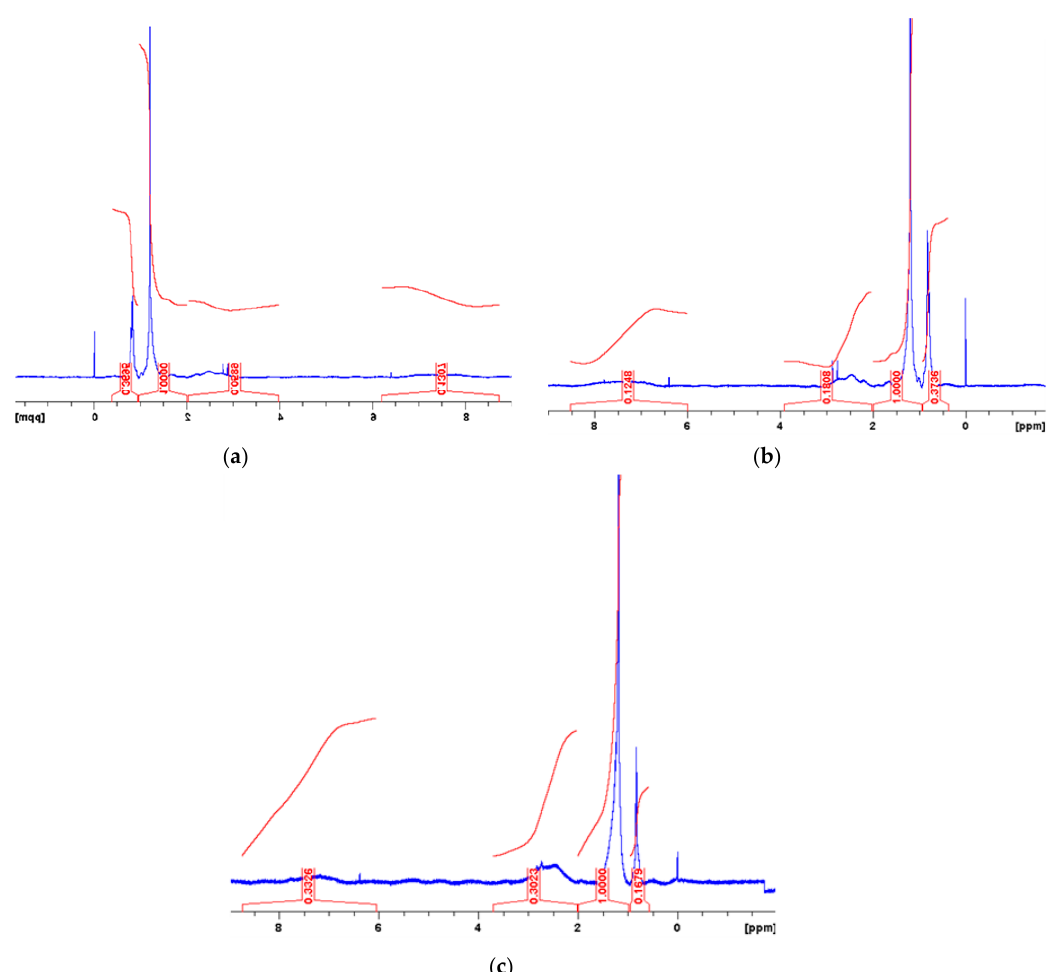
Figure 4. The 1 H-NMR spectra of Paving 70/100 bitumen in CCl 4 : ( a ) neat bitumen; ( b ) maltene fraction; and ( c ) asphaltene fraction.